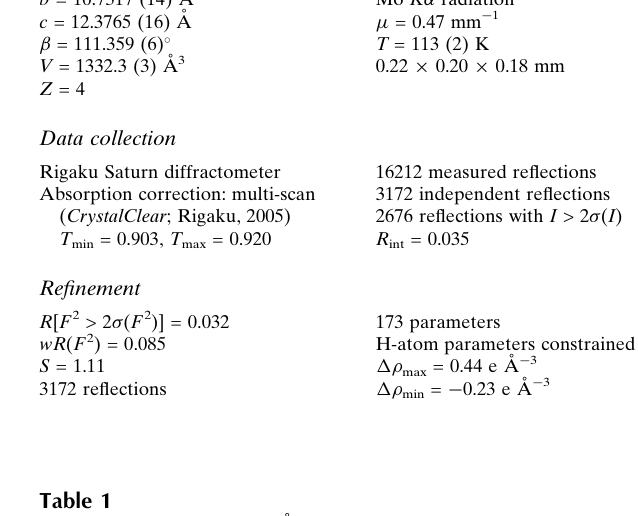
Rigaku Saturn diffractometer Absorption correction: multi-scan